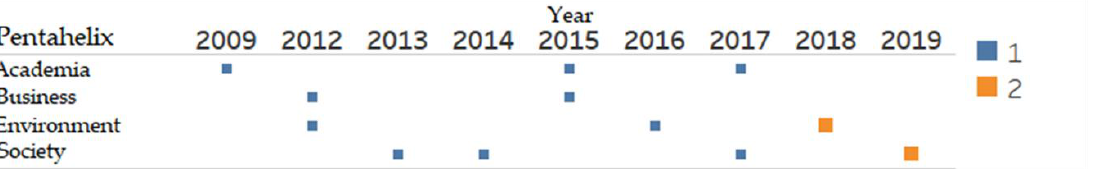
Figure 5. Grouping of SAK’s experiences by pentahelix sector and year.